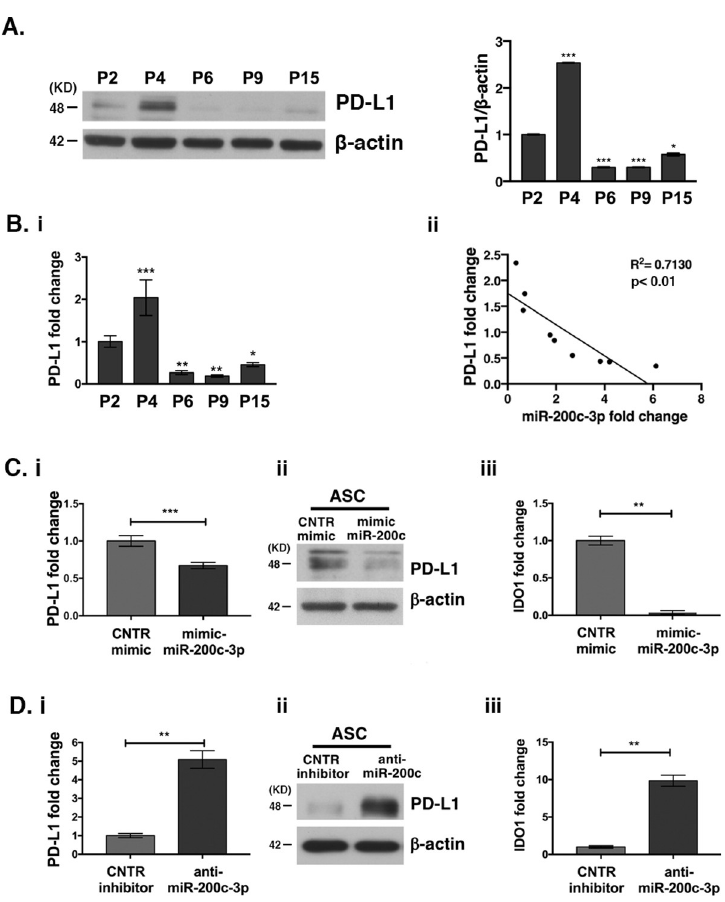
Fig 5. MiR-200c-3p inverse correlates with PD-L1 expression and modulates PD-L1 and IDO1 expression in ASCs. A. PD-L1 expression at P2-P15 passages was assessed by WB. Densitometric analysis measures the fold change of PD-L1 expression normalized to β -actin in each passage. One out of two WBs is shown. Dunnett’s multiple comparisons test was applied to compare P2 with each of the passages. � p < 0.05, ��� p < 0.001. B. (i): PD-L1 mRNA detection by QRT-PCR, during in vitro passages (P). PD-L1 expression was normalized to GAPDH. SD ± are the mean of three independent experiments. Dunnett’s multiple comparisons test was applied to compare P2 with each of the passages. � p < 0.05, �� p < 0.01, ��� p < 0.001. (ii): Correlation analysis between PD-L1 and miR-200c-3p expression was performed in ASCs derived from 5 healthy donors at all passages from 2 to 15. The square of the correlation coefficient, R 2 < 0.7 shows that the inverse correlation is significant with p < 0.01. C. (i): PD-L1 transcript fold change by qRT-PCR in ASCs transfected with miR-200c-3p mimics, at P4 and (ii): PD-L1 protein detection by WB. (iii): IDO1 transcript fold change by qRT-PCR in ASCs transfected with miR-200c-3p mimics, at P4. D. (i): PD-L1 transcript by qRT-PCR in ASCs transfected with miR-200c-3p inhibitors, at P9 and (ii): PD-L1 protein detection by WB. and (iii): IDO1 transcript fold change by qRT-PCR in ASCs transfected with miR-200c-3p inhibitor, at P9. SD ± is the mean of three experiments and the p values were calculated with two tailed unpaired t test. �� p < 0.01, ��� p < 0.001.